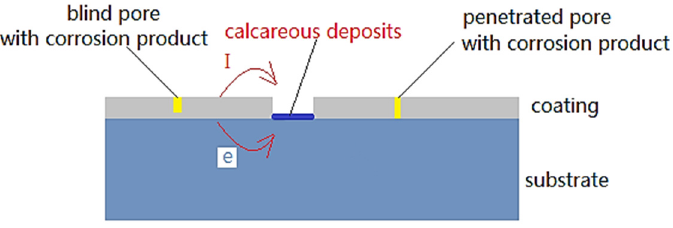
Figure 1. The schematic of protection effects of the cold ‐ sprayed AlZn coating in solution.